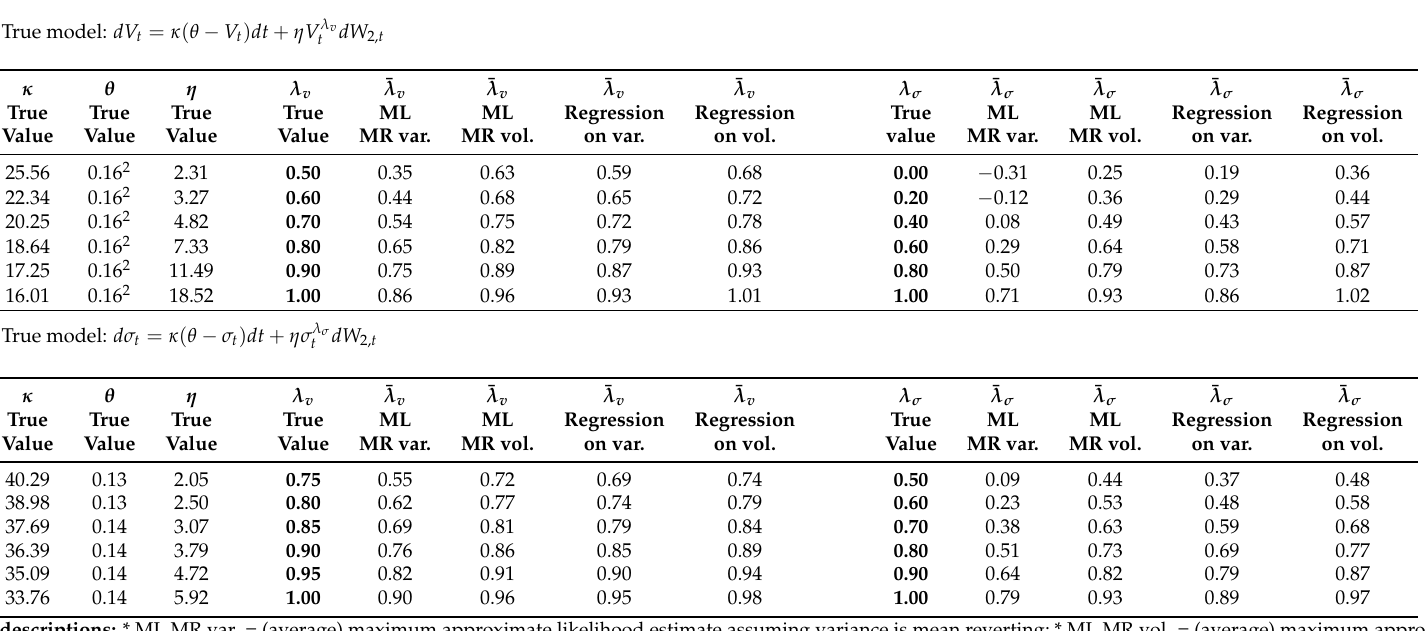
and { ˆ λ σ , i } N , respectively. The goal is then to i = 1 i = 1 ¯ λ ˆ λ ˆ λ 1 ∑ N ∑ N σ = σ , i (columns 5–8) and σ , i √ √ i = 1 i = 1 N N N and ˆ ν σ / N , where we